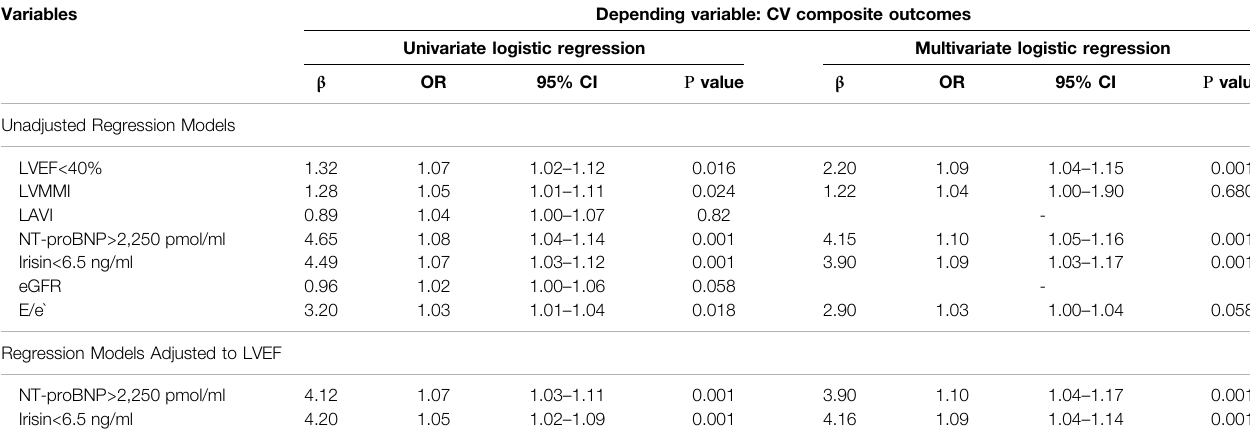
TABLE 2 | Factors contributing CV composite outcomes in HF patients with T2DM: Results of univariate and multivariate logistic regression analysis. Variables Depending variable: CV composite outcomes Univariate logistic regression Multivariate logistic regression